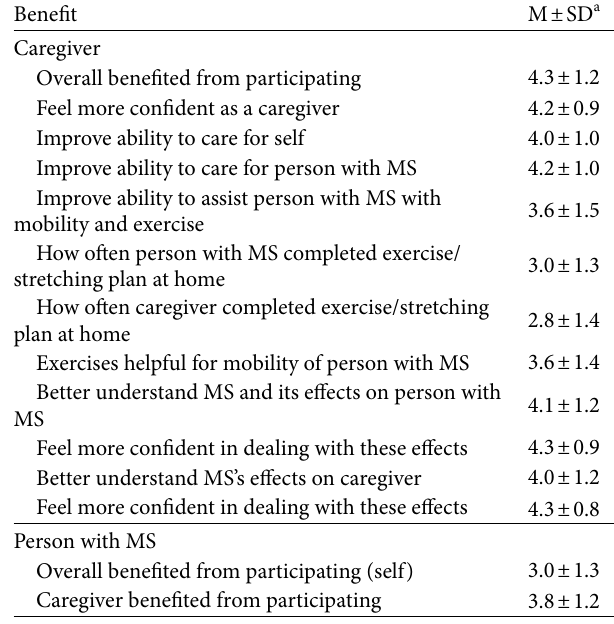
Table 2: Benefits of participation reported by caregiver and person with